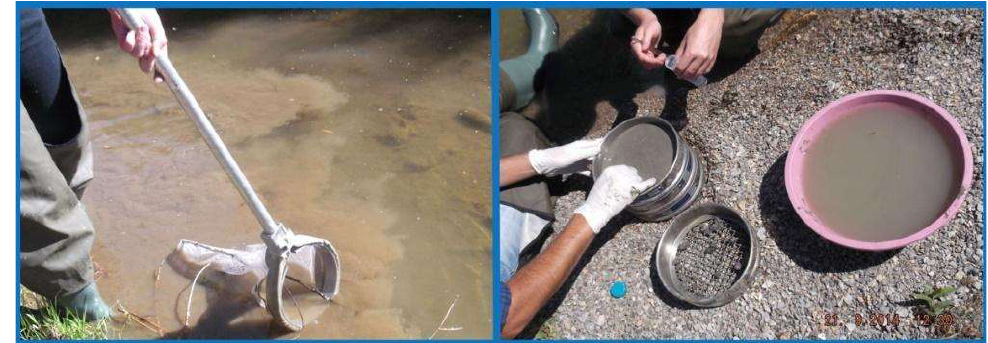
Figure 2. On the left : collecting gastropods with hand zooplankton net in Üstünler Stream; on the right : collecting gastropods with girdles, pincers, and by hand in Suğla Reservoir; photographed by Ahmet Altındağ on September 2014.